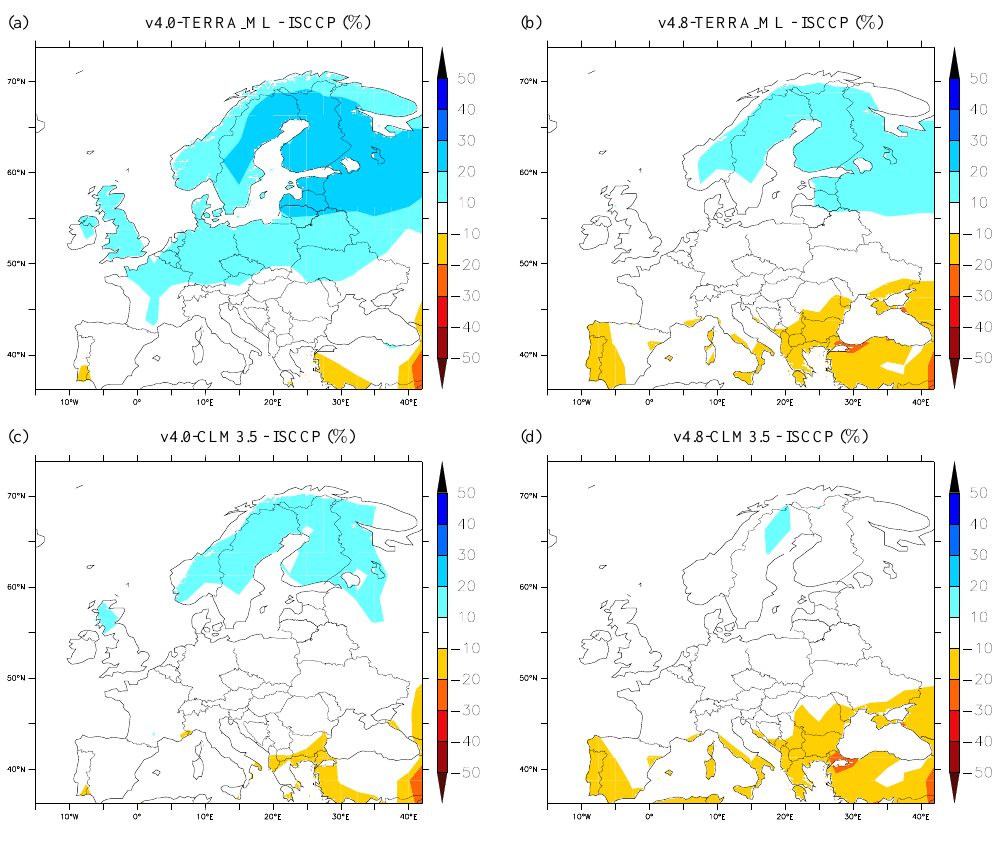
Fig. 3. Same as Figure 2 but in reference to ISCCP instead of CRU. Fig. 3. Same as Fig. 2 but in reference to ISCCP instead of